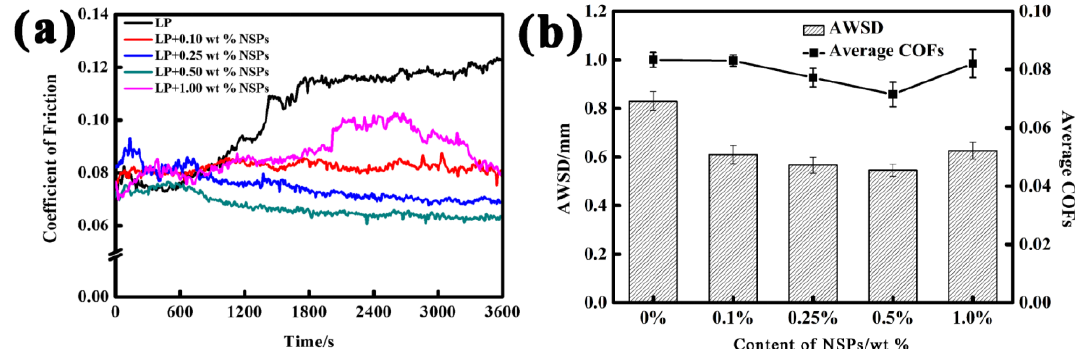
Figure 2. Coefficients of friction (COFs) of samples as a function of sliding time ( a ), and average wear scar diameter and COFs at different contents ( b ).